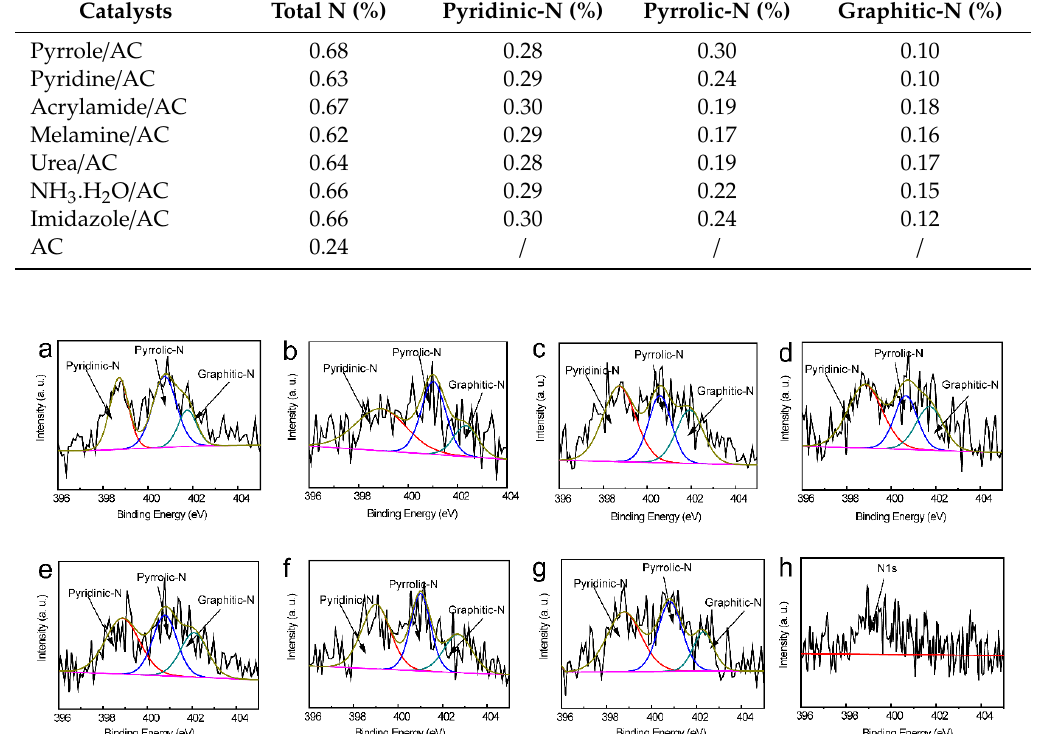
Figure 2. The high-resolution N1s XP spectra of the different N-doped catalysts ( a ) Pyrrole/AC, ( b ) Pyridine/AC, ( c ) Acrylamide/AC, ( d ) Melamine/AC, ( e )Urea/AC, ( f ) NH 3 .H 2 O/AC, ( g ) Imidazole/AC, and ( h ) AC.